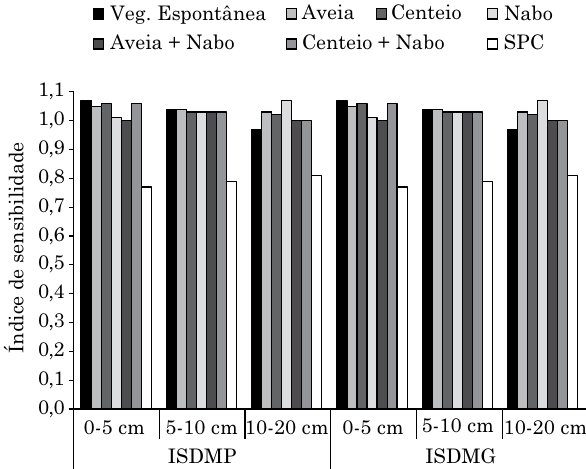
Figura 2. Índice de sensibilidade para diâmetro médio ponderado (iSdmP) e diâmetro médio geométrico (iSdmg) de agregados em sistemas de uso do solo com cultivo de cebola, em relação à mata, nas profundidades de 0-5, 5-0 e 10-20